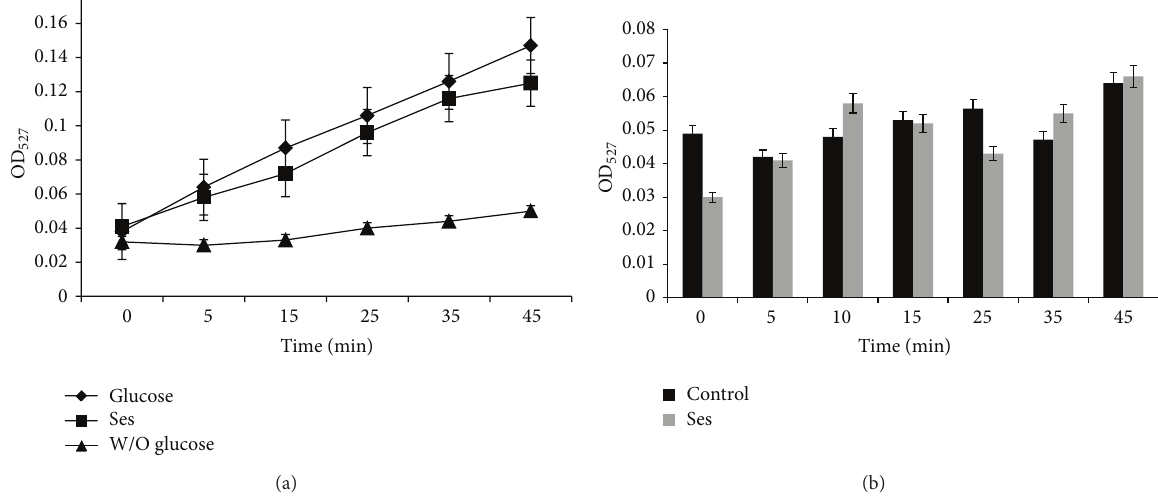
Figure 3: Drug efflux assay and passive diffusion in presence of Ses. (a) Extracellular concentrations of R6G for C. albicans (ATCC 10261) cells grown in absence (control) and presence of Ses (0.552 mg/mL) calculated as described in material and methods. Negative control represents C. albicans deenergized cells without glucose. Mean of OD 527 ± SD of three independent sets of experiments are depicted on 𝑦 -axis with respect to time (minutes) on 𝑥 -axis. ( 𝑃 value > 0.05). (b) Passive diffusion of R6G in absence (control) and presence of Ses (0.552 mg/mL) calculated as described in Section 2. Mean of OD 527 ± SD of three independent sets of experiments are depicted on 𝑌 -axis with respect to time (minutes) on 𝑥 -axis ( 𝑃 value >